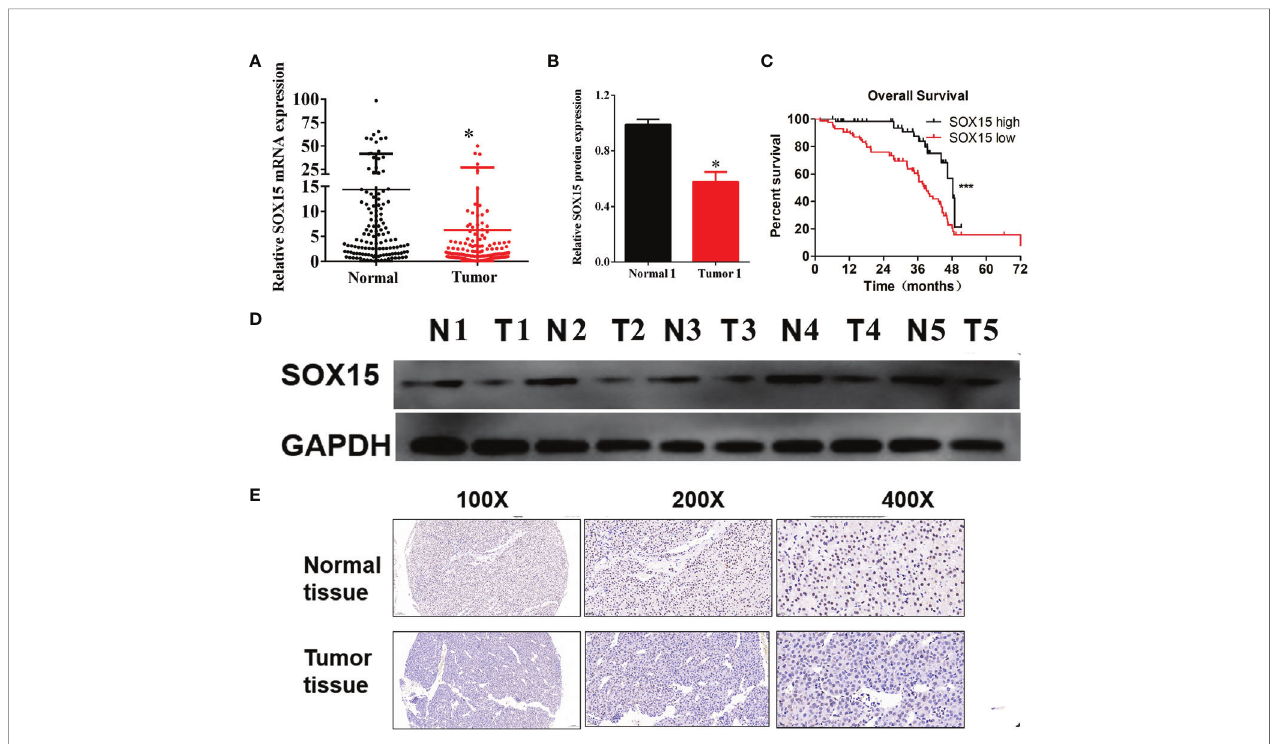
FIGURE 2 | The expression of Sox15 is reduced and positively correlates with prognosis in HCC as analyzed by our cohort. (A) Sox15 mRNA levels within HCC as well as paraneoplasia samples measured through RT-qPCR. (B) Quanti fi cation of Sox15 protein levels of the representative HCC and its paraneoplasia samples shown in panel (C, D) KM analysis suggested that HCC cases with reduced Sox15 levels suffered worse OS. (D) Sox15 protein levels of the indicated HCC and its paraneoplasia samples measured by Western Blot. (E) Sox15 protein levels within HCC and its paraneoplasia tissues measured by IHC. *p < 0.05, ***p <